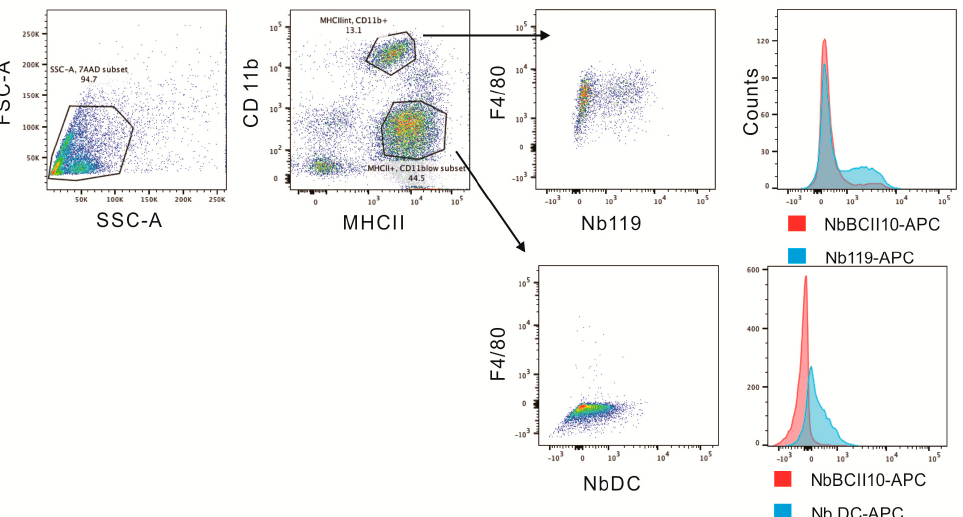
Figure 1. Nb119 binds to F4 / 80 + CD11b + MHCII intermediate peritoneal macrophages. The peritoneal cavity cells from B7 naive mice were gated according to MHCII and CD11b expression. MHCII intermediate and CD11b + population shows F4 / 80 positive and Nb119 positive. F4 / 80 low MHCII high population is Nb119 negative. Flow cytometry histogram plots of APC-labeled Nb119 (blue) and are shown in comparison with an APC-labeled rat IgG2a kappa isotype control antibody (red).